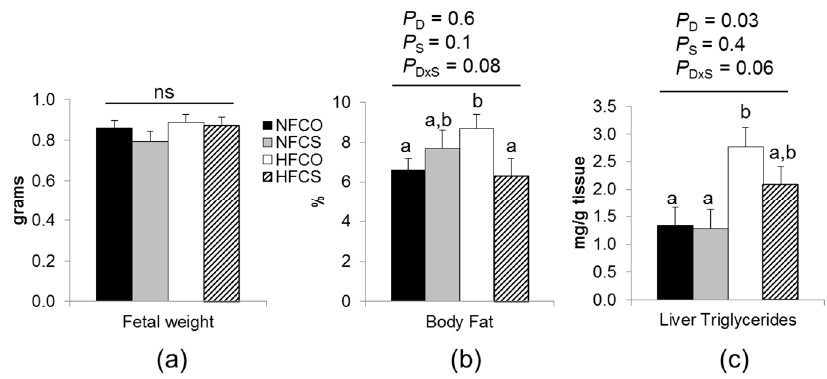
Figure 3. Fetal weight and adiposity at E17.5. ( a ) Fetal weight; ( b ) percent total body fat of fetuses; ( c ) fetal liver triglyceride concentrations. Experimental diets were fed to dams from 6 weeks before timed-mating to gestational day 17.5. Data were analyzed using the general linear model. Posteriori analysis of variance (ANOVA) followed by posthoc Fisher's least significant difference (LSD) analysis between groups was conducted with p D × S ≤ 0.2. NFCO (solid bars): n = 9; NFCS (shaded bars): n = 6; HFCO (open bars): n = 7; HFCS (hatched bars): n = 6. n is the number of dams. Fetal weight was analyzed with pooled data of all fetuses in each dam (5–10/dam); body fat and liver triglyceride concentrations were analyzed with pooled data of two randomly selected fetuses in each dam. Values are mean ± standard error of mean (SEM); different letters indicate p < 0.05 in the posthoc analysis. ns: p D , p S , and p D × S , not significant. CO: control; CS: choline supplemented; D: diet; HF: high-fat diet; NF: normal-fat diet; S: supplementation.